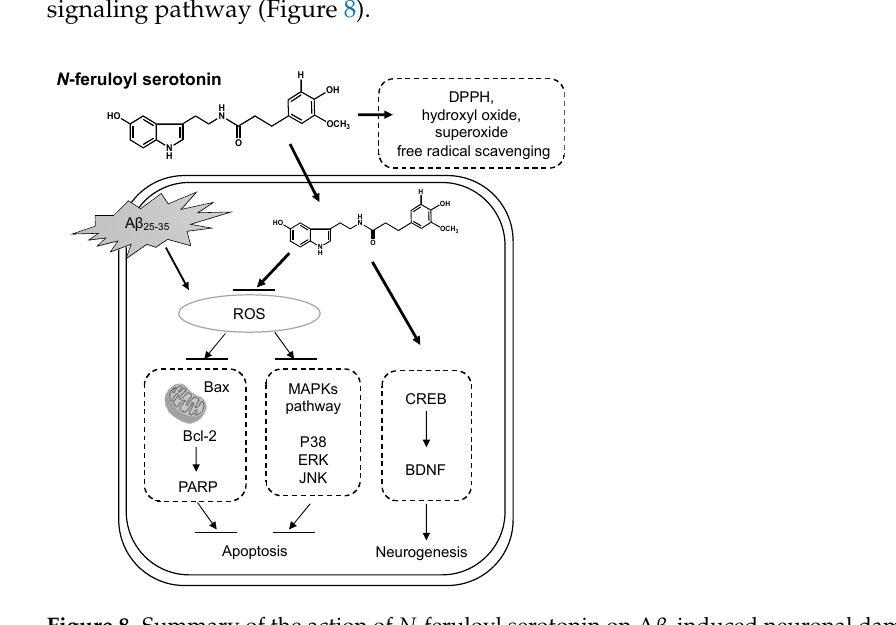
Figure 8. Summary of the action of N -feruloyl serotonin on A β -induced neuronal damage.